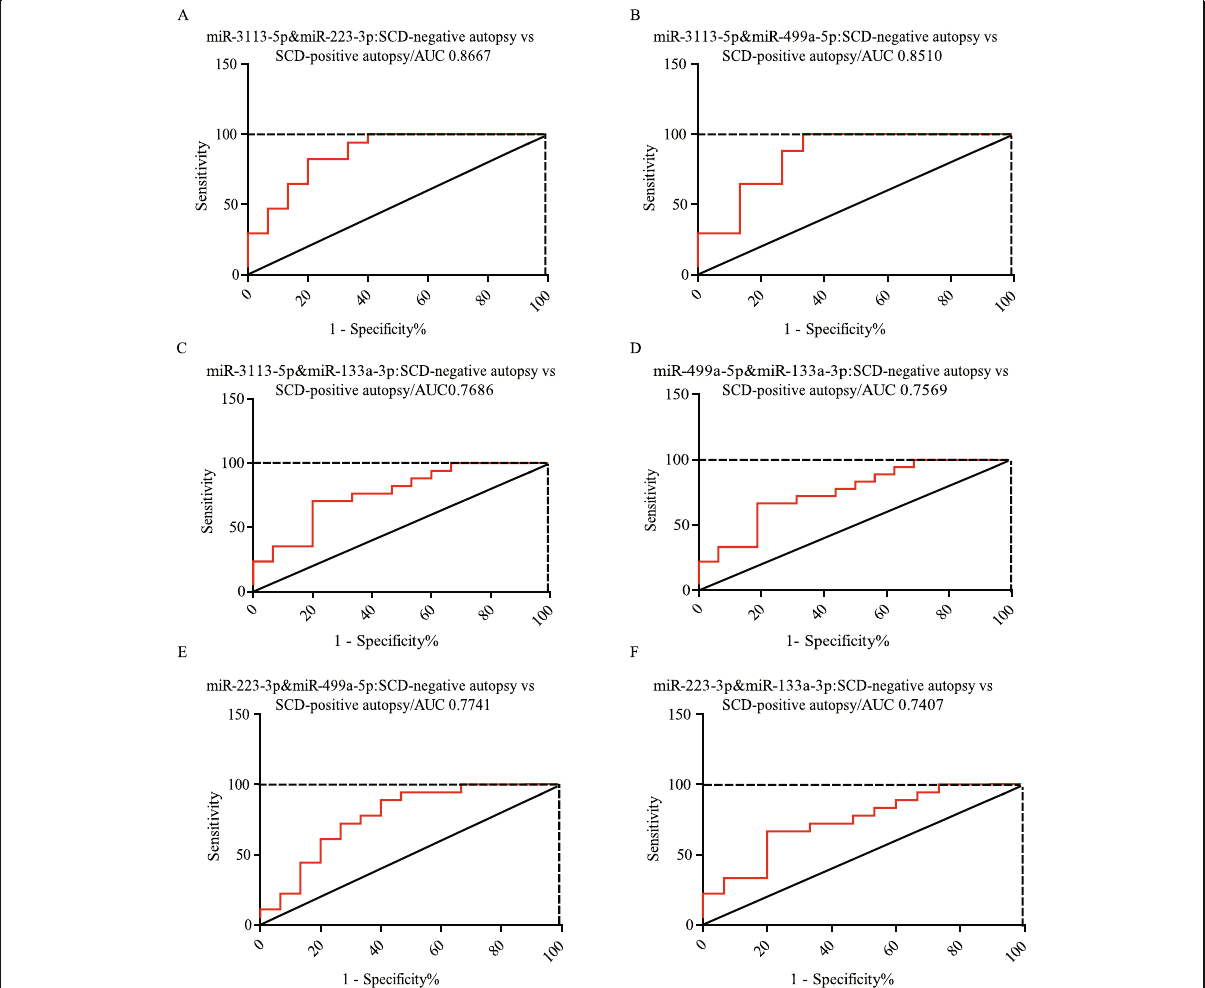
Fig. 6 Diagnostic performance of miRNAs was analyzed by ROC curve. The ROC analysis for detection of SCD-positive autopsy and SCD-negative autopsy using a combination of miR-3113-5p and miR-223-3p ( A ), a combination of miR-3113-5p and miR-499a-5p ( B ), a combination of miR- 3113-5p and miR-133a-3p ( C ), a combination of miR-499a-5p and miR-133a-3p ( D ), a combination of miR-223-3p and miR-499a-5p ( E ), a combination of miR-223-3p and miR-133a-3p ( F ) were shown